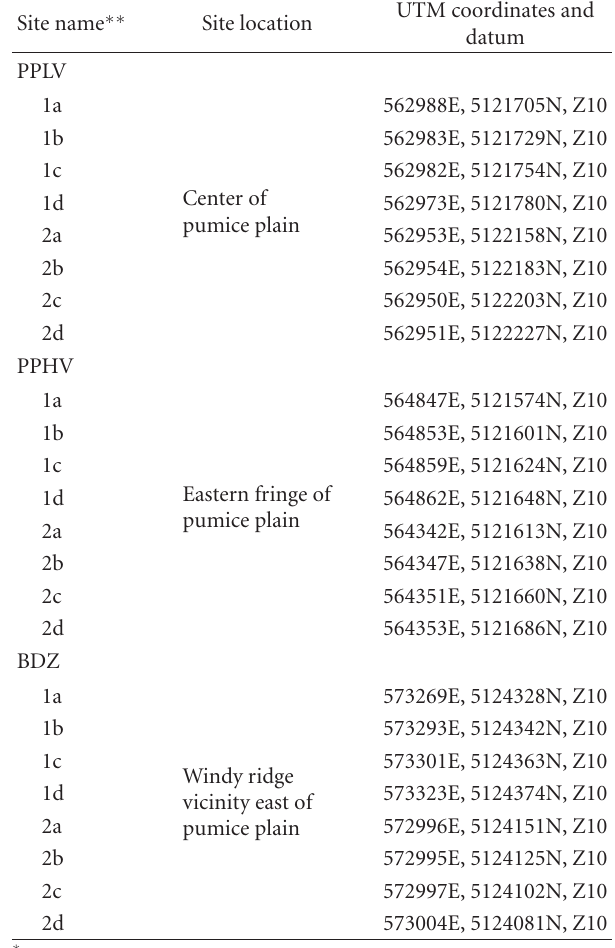
Table 1: Description of 6 study sites ∗